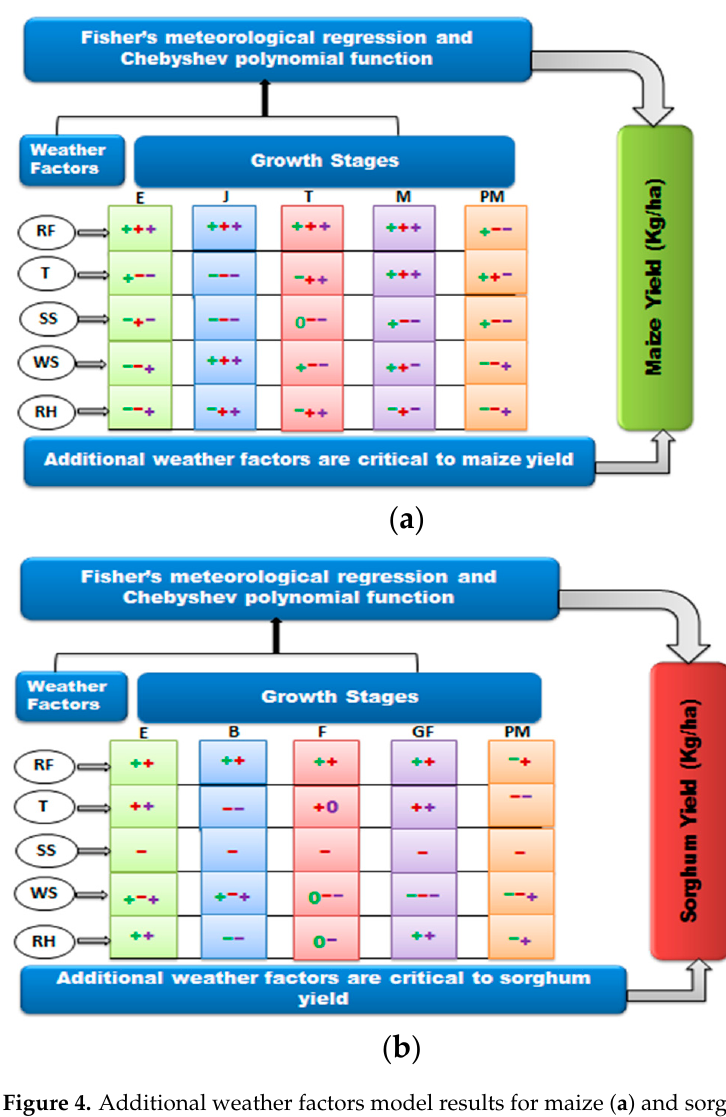
Figure 4. Additional weather factors model results for maize ( a ) and sorghum ( b ) yields.